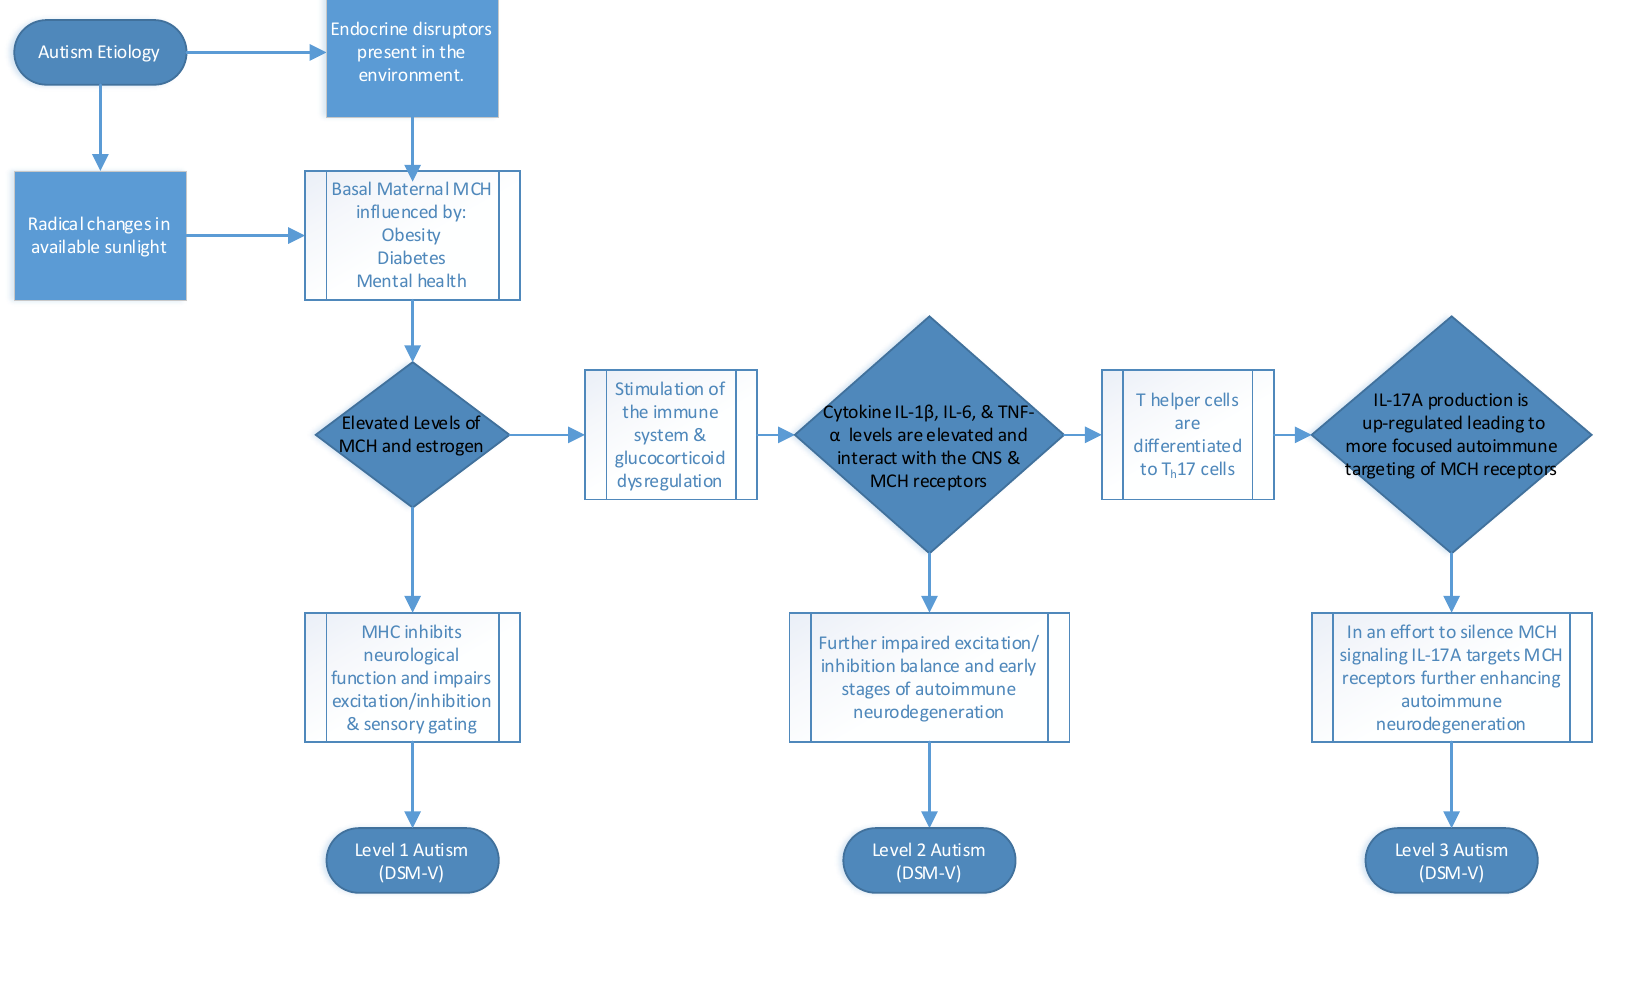
Figure 2. The positive endocrine feedback loop may predict for ASD diagnosis depending on severity of dysregulation of the associated systems. The autoimmune activity may be a reactionary final measure to silence the excess signaling of MCH receptors. IL-6 has potential to suppress MCH receptor activity while IL-17A aggressively targets MCH receptors in autoimmune disorders (i.e. vitiligo). When IL-6 fails to suppress MCH signaling its overexpression leads to T helper cell differentiation to Th17 cell types and overexpression of IL-17A. Significant developmental interruption of neurogenesis and functional connectivity occurs with moderate dysregulation of MCH expression with more severe MCH system dysregulation enhancing the potency of cytokines facilitating neurodegeneration to arrest aberrant MCH signaling. This interaction is made possible through the suppression of POMC and diminished glucocorticoid negative feedback on the hypothalamus resulting from MCH inhibition of ACTH and estrogen reduci ng glucocorticoid